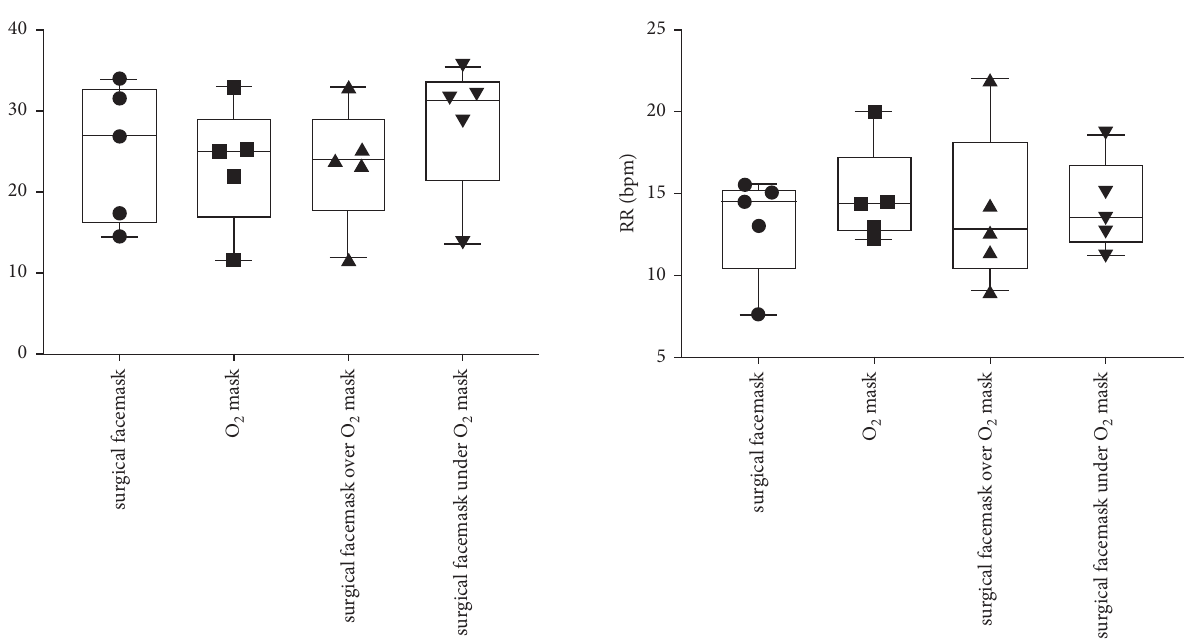
Figure 3: Box and Whisker plots of sampled EtCO Figure 4: Box and Whisker plots of respiratory rate (RR) measured 2 at the lips with a surgical facemask only, an O 2 mask only, a surgical facemask over as breaths per minute computed using capnography with a surgical an O 2 mask, and a surgical facemask under an O 2 mask. The circles, facemask only, an O 2 mask only, a surgical facemask over an O 2 squares, and triangles represent average values for each of the five mask, and a surgical facemask under an O 2 mask. The circles, subjects in the various mask configurations. squares, and triangles represent average values for each of the five subjects in the various mask